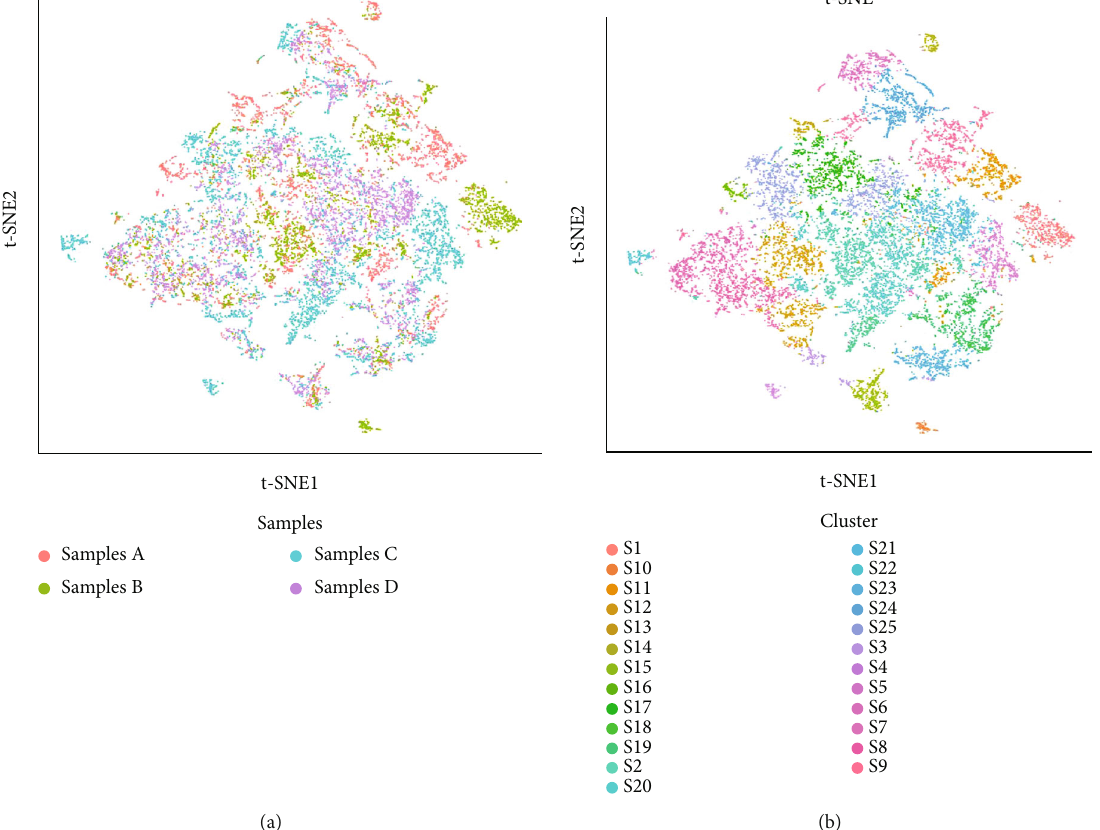
Figure 2: Cluster analysis of OSCC samples. (a) Single cells from each PhenoGraph cluster in four samples of OSCC with lymph node metastasis displayed by t-SNE descending dimension map were colored-coded in heat map images. The colors represent di ff erent samples. (b) t-SNE descending dimension map displays single cells from each PhenoGraph cluster. They are identi fi ed in heat map images colored according to individual cluster. Colors represent di ff erent clusters of immune cells. OSCC: oral squamous cell